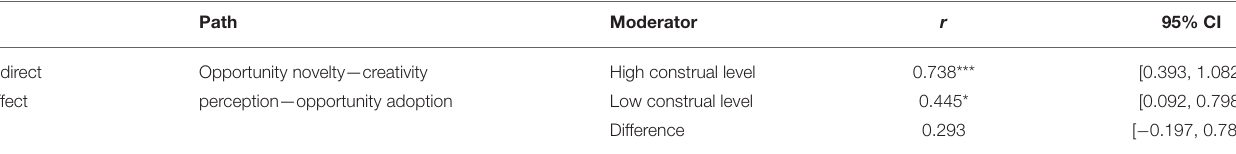
TABLE 5 | Results for the moderated